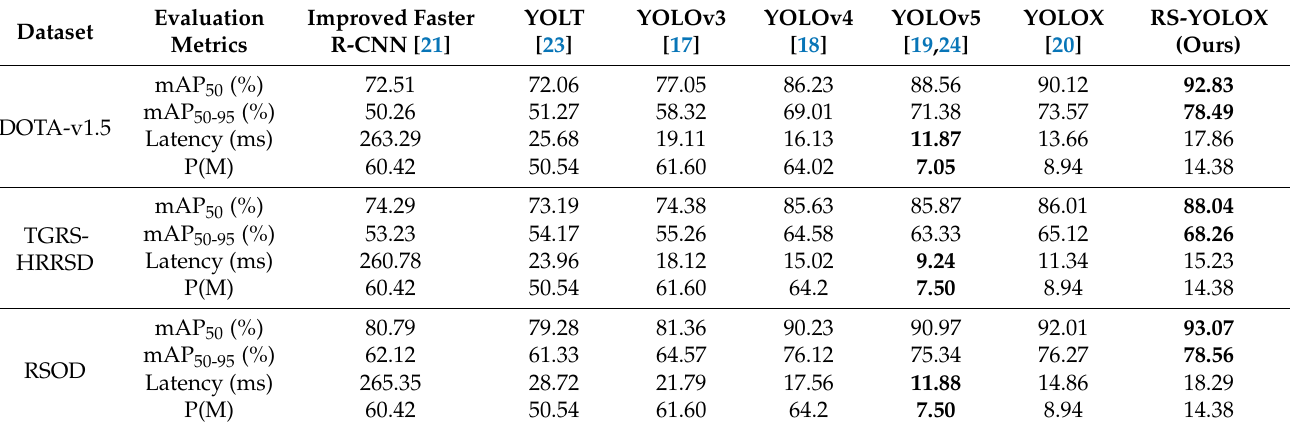
Table 7. Performance comparison of advanced object detection models on aerial remote sensing